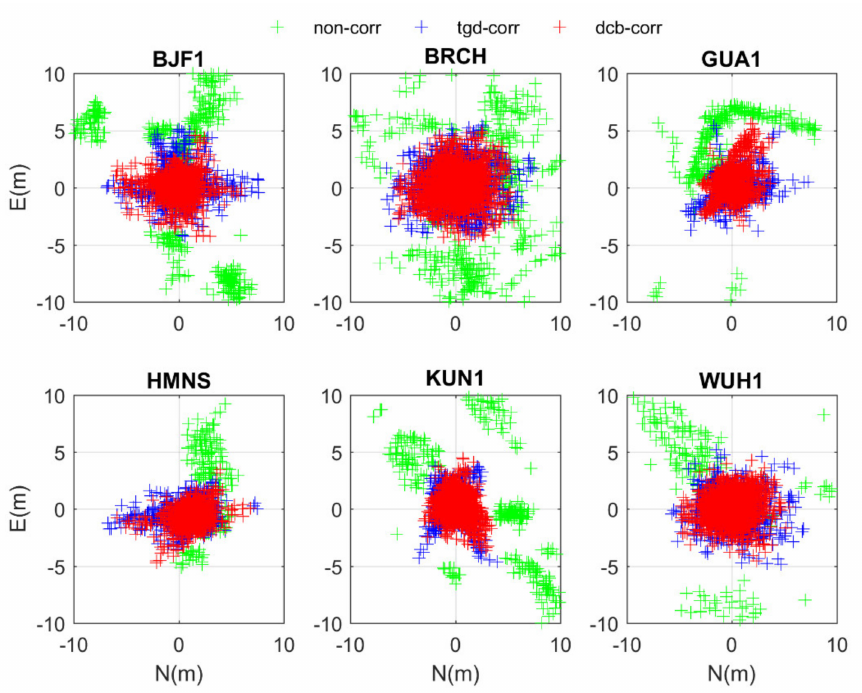
Figure 15. Horizontal positioning error scatters with and without TGD or DCB correction of B1I/B3I SPP at six stations.